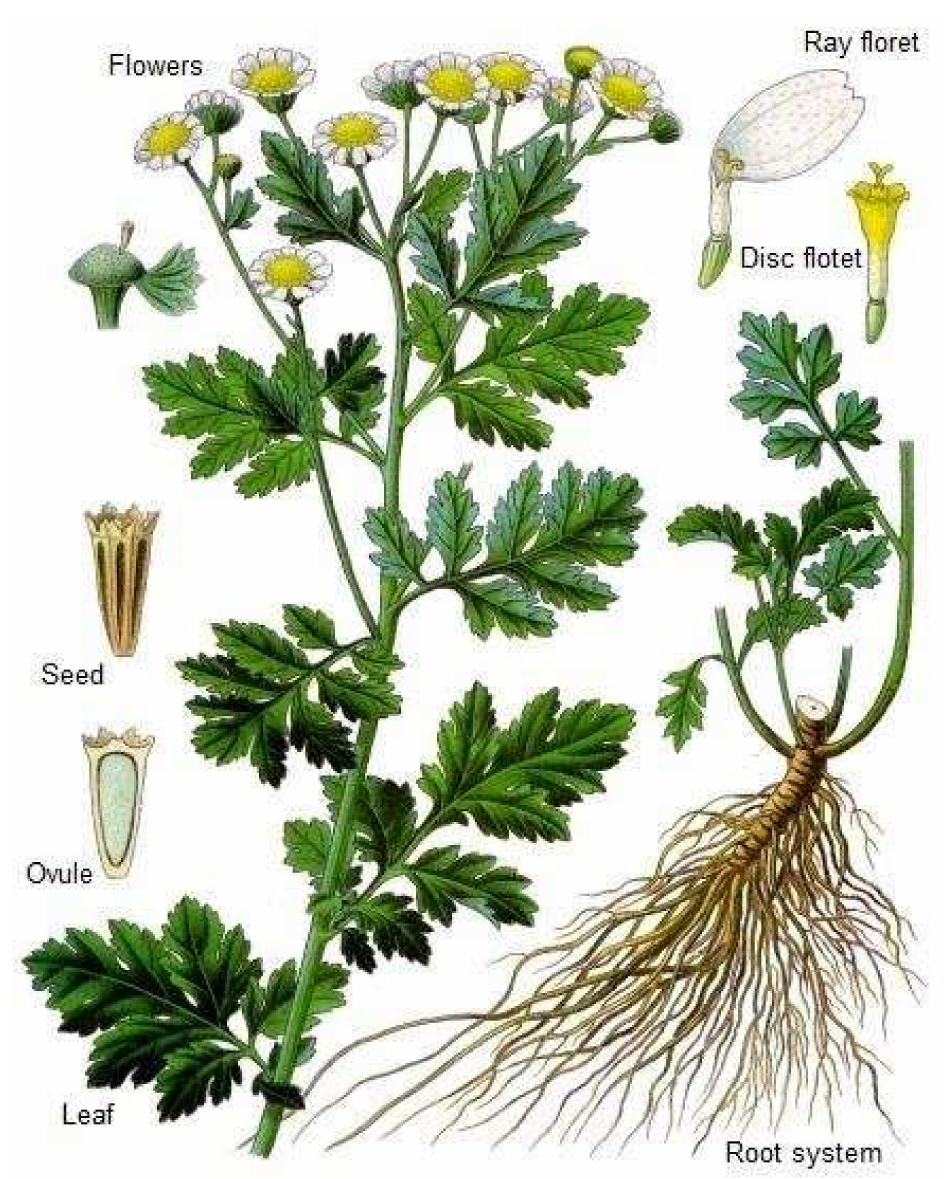
Figure 1. The different plant parts of Parthenium hysterophorus